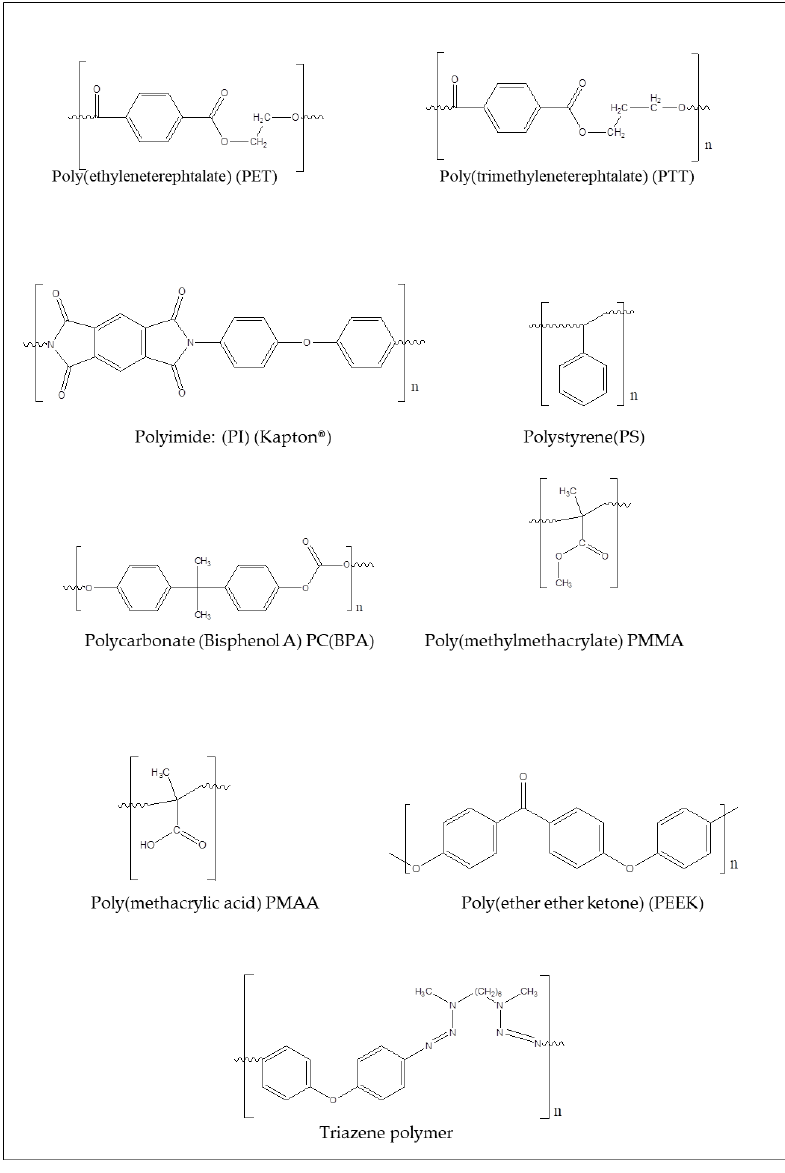
Scheme 2. Chemical structure of the monomer units of homopolymers structured by